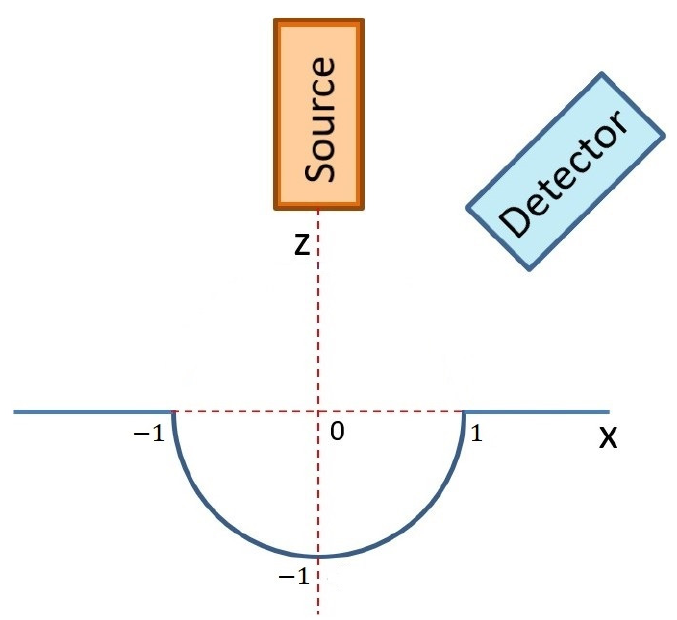
Figure 8. Scheme of Monte Carlo simulation of XRF scanning of an artifact represented by a sphere- shaped hole with a radius of 1 mm.